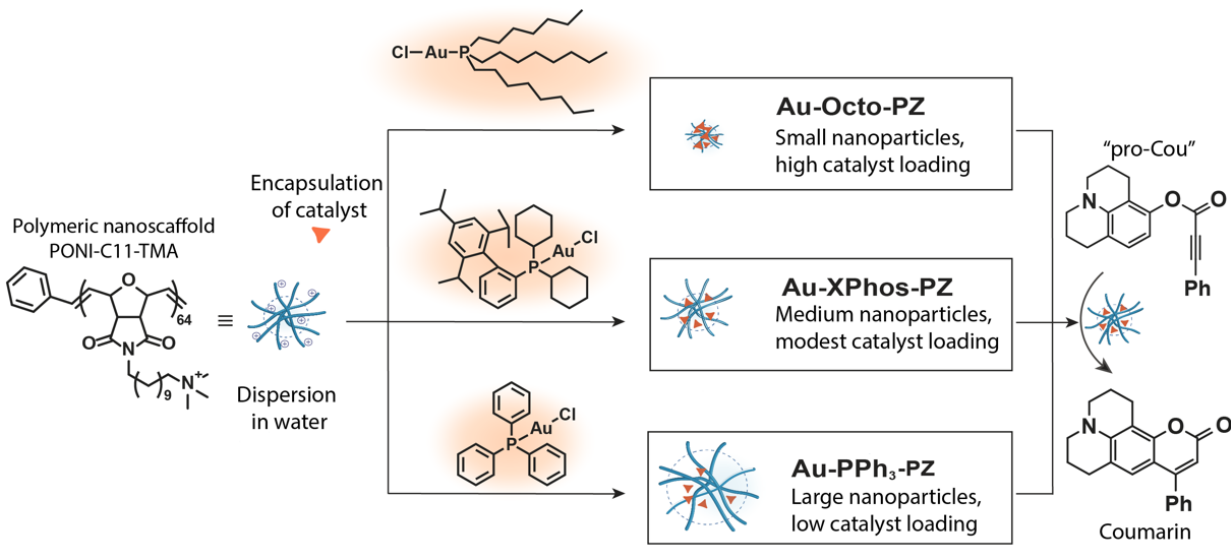
Figure 1. The encapsulation of gold TMCs into polymer scaffolds affords polyzymes. Variation in the ligand structure of the TMC leads to the generation of differently sized nanoparticles along with changes in the catalyst loading.